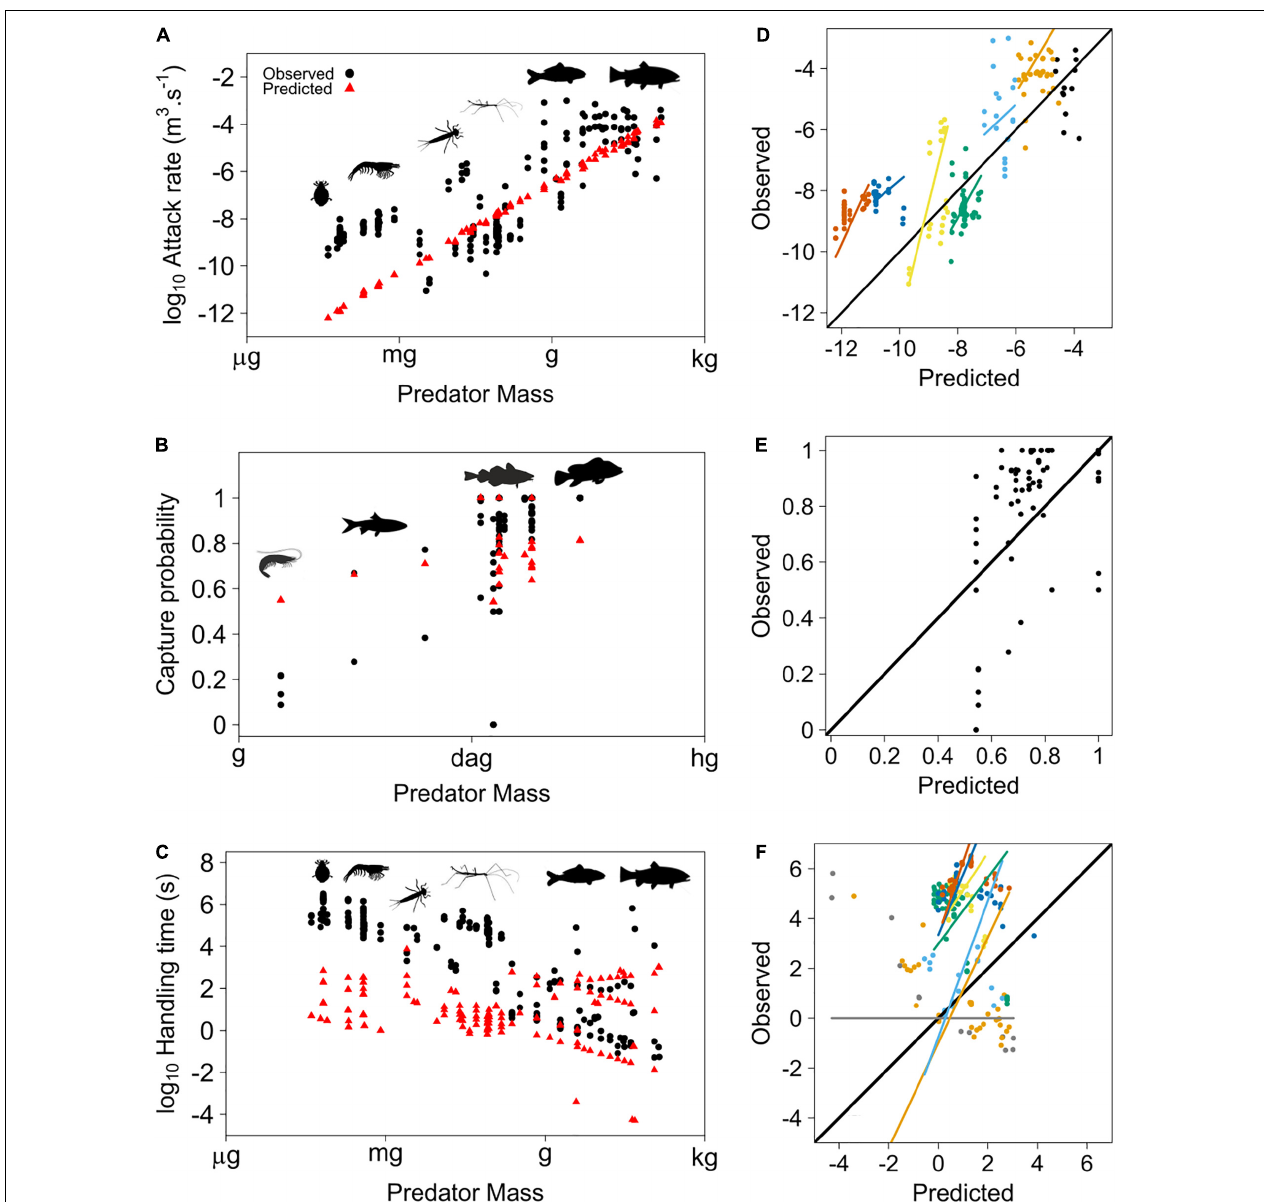
FIGURE 2 | Predator attack rate (A) , capture probability (B) and handling time (C) according to predator mass in aquatic systems. The model fits the data quite well for attack rate (except for very small organisms) and capture probability. However, data show some variability. Predictions for handling time are more accurate for relatively large predators than for smaller predators. This suggests that more investigations are needed in order to understand how mechanical factors constrain handling time for predators according to predator and prey sizes. (D–F) are the observed versus predicted data (same as Figure 1 ) for attack rate, capture probability and handling time, respectively. The colored regression lines are non-significant in (D) , but significant in (F) .